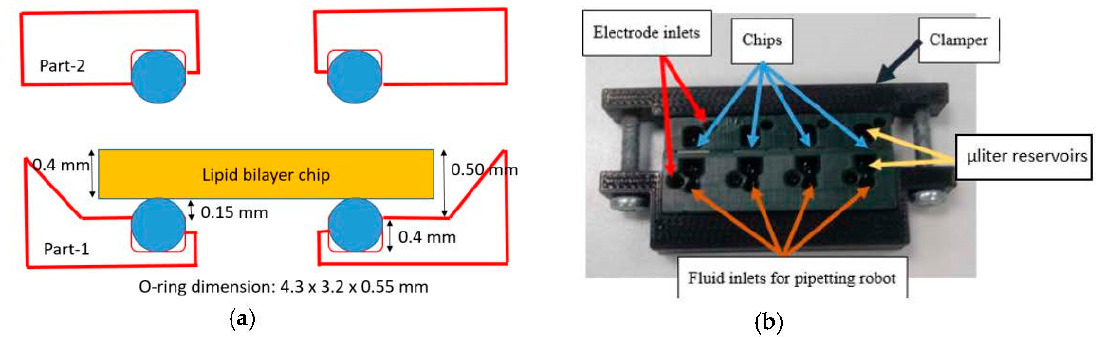
Figure 2. Parallel bilayer analysis platform: ( a ) Chip slot design with O-ring incorporation; ( b ) Complete measuring setup fixed by a clamper.